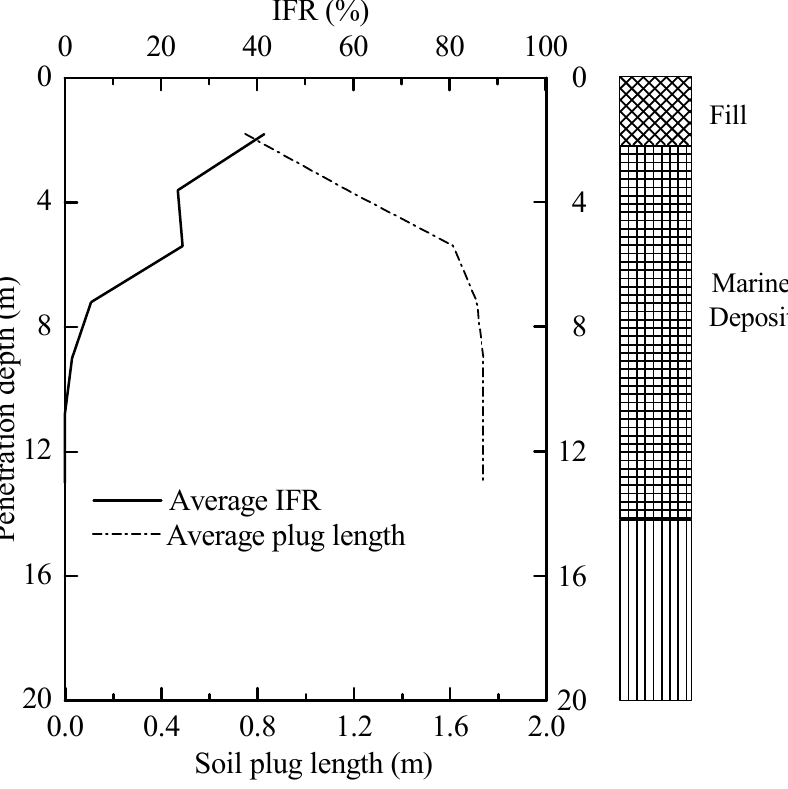
Figure 11. IFR and soil plug length versus penetration depth for test piles.